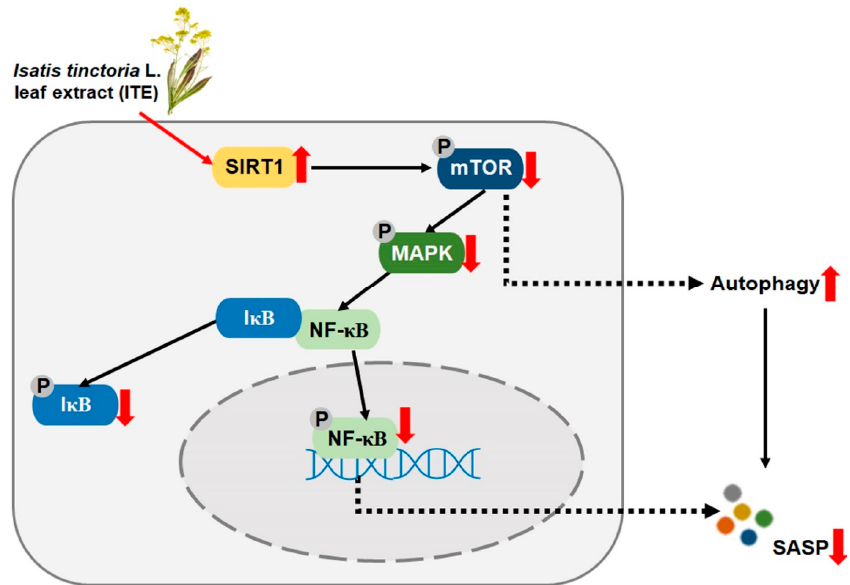
Figure 7. The role of ITE in senomorphic effects through the SIRT1/mTOR/MAPK/NF- κ B signaling pathway in RS-HDFs.